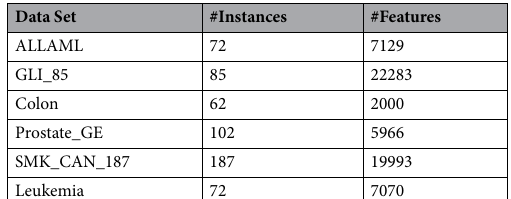
Table 6. Bioinformatics datasets used in